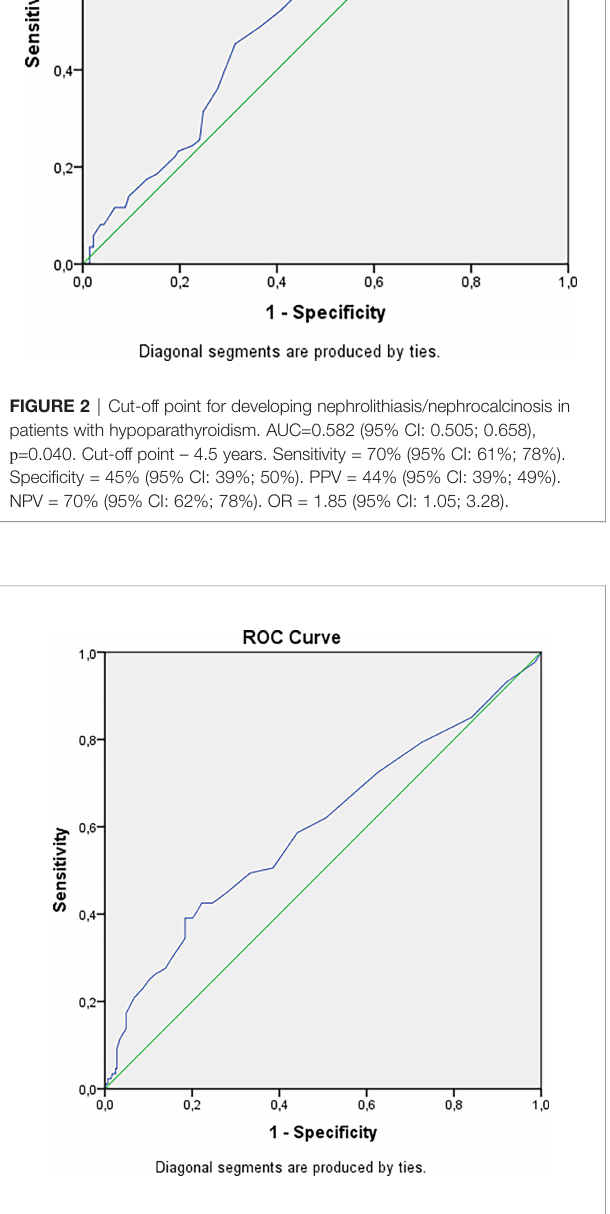
FIGURE 3 | Cut-off point for decreasing GFR in patients with hypoparathyroidism. AUC=0.598 (95% CI: 0.526; 0.670), р =0.006. Cut-off point – 13.5 years. Sensitivity = 39% (95% CI: 30%; 48%). Speci fi city = 82% (95% CI: 79%; 84%). PPV = 39% (95% CI: 30%; 48%). NPV = 82% (95% CI: 79%; 84%). OR = 2.84 (95% CI: 1.69; 4.80).